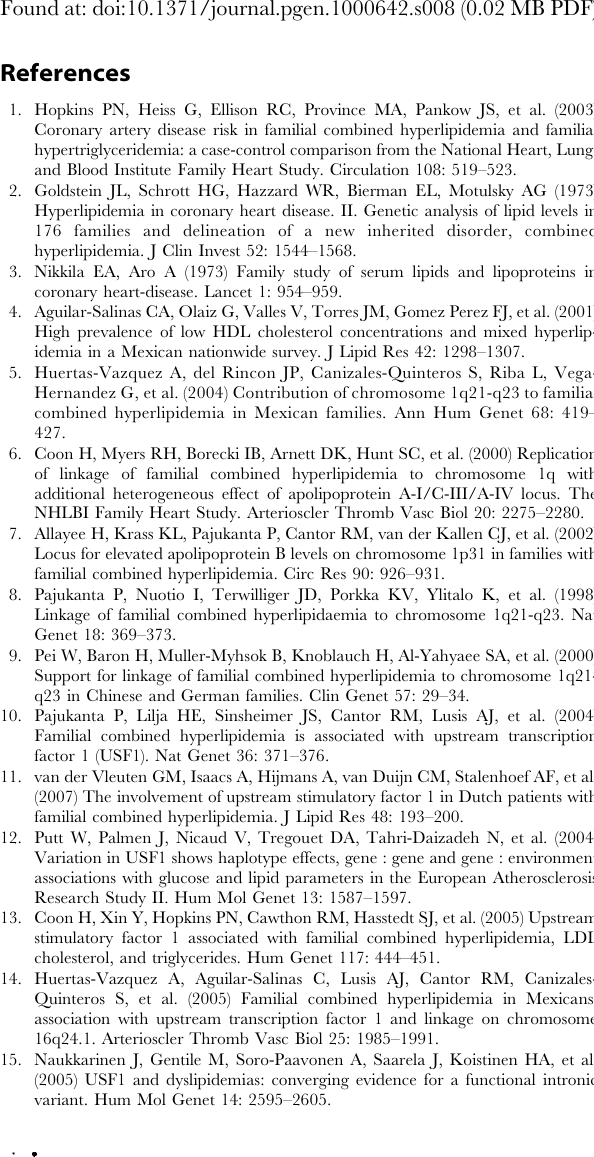
Table S2 Genes correlated to FCHL-associated rs3737787 genotypes (additive model) in Mexican FCHL case/control fat biopsies (p-value # 0.05). Table S3 Genes differentially expressed between FCHL cases and normolipidemic controls in Mexican FCHL case/control fat biopsies (p-value # 0.05). Table S4 WGCNA module membership for all probes from the Mexican FCHL case/control fat biopsies.